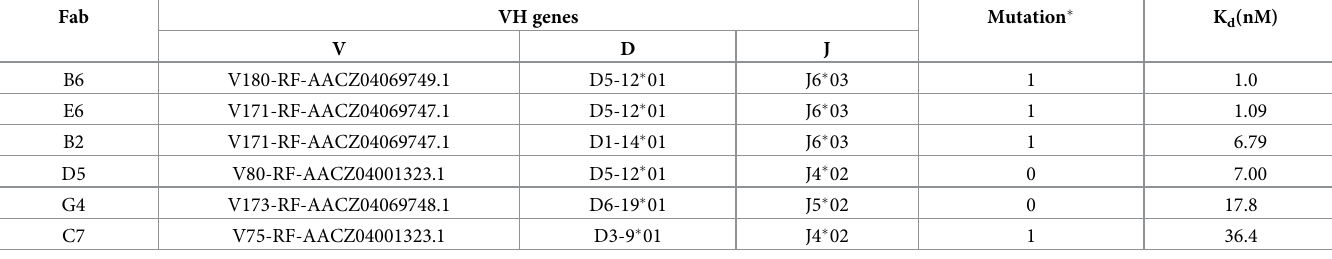
Table 1. Binding affinities of selected anti-core Fabs in germline configuration. Fab VH genes Mutation